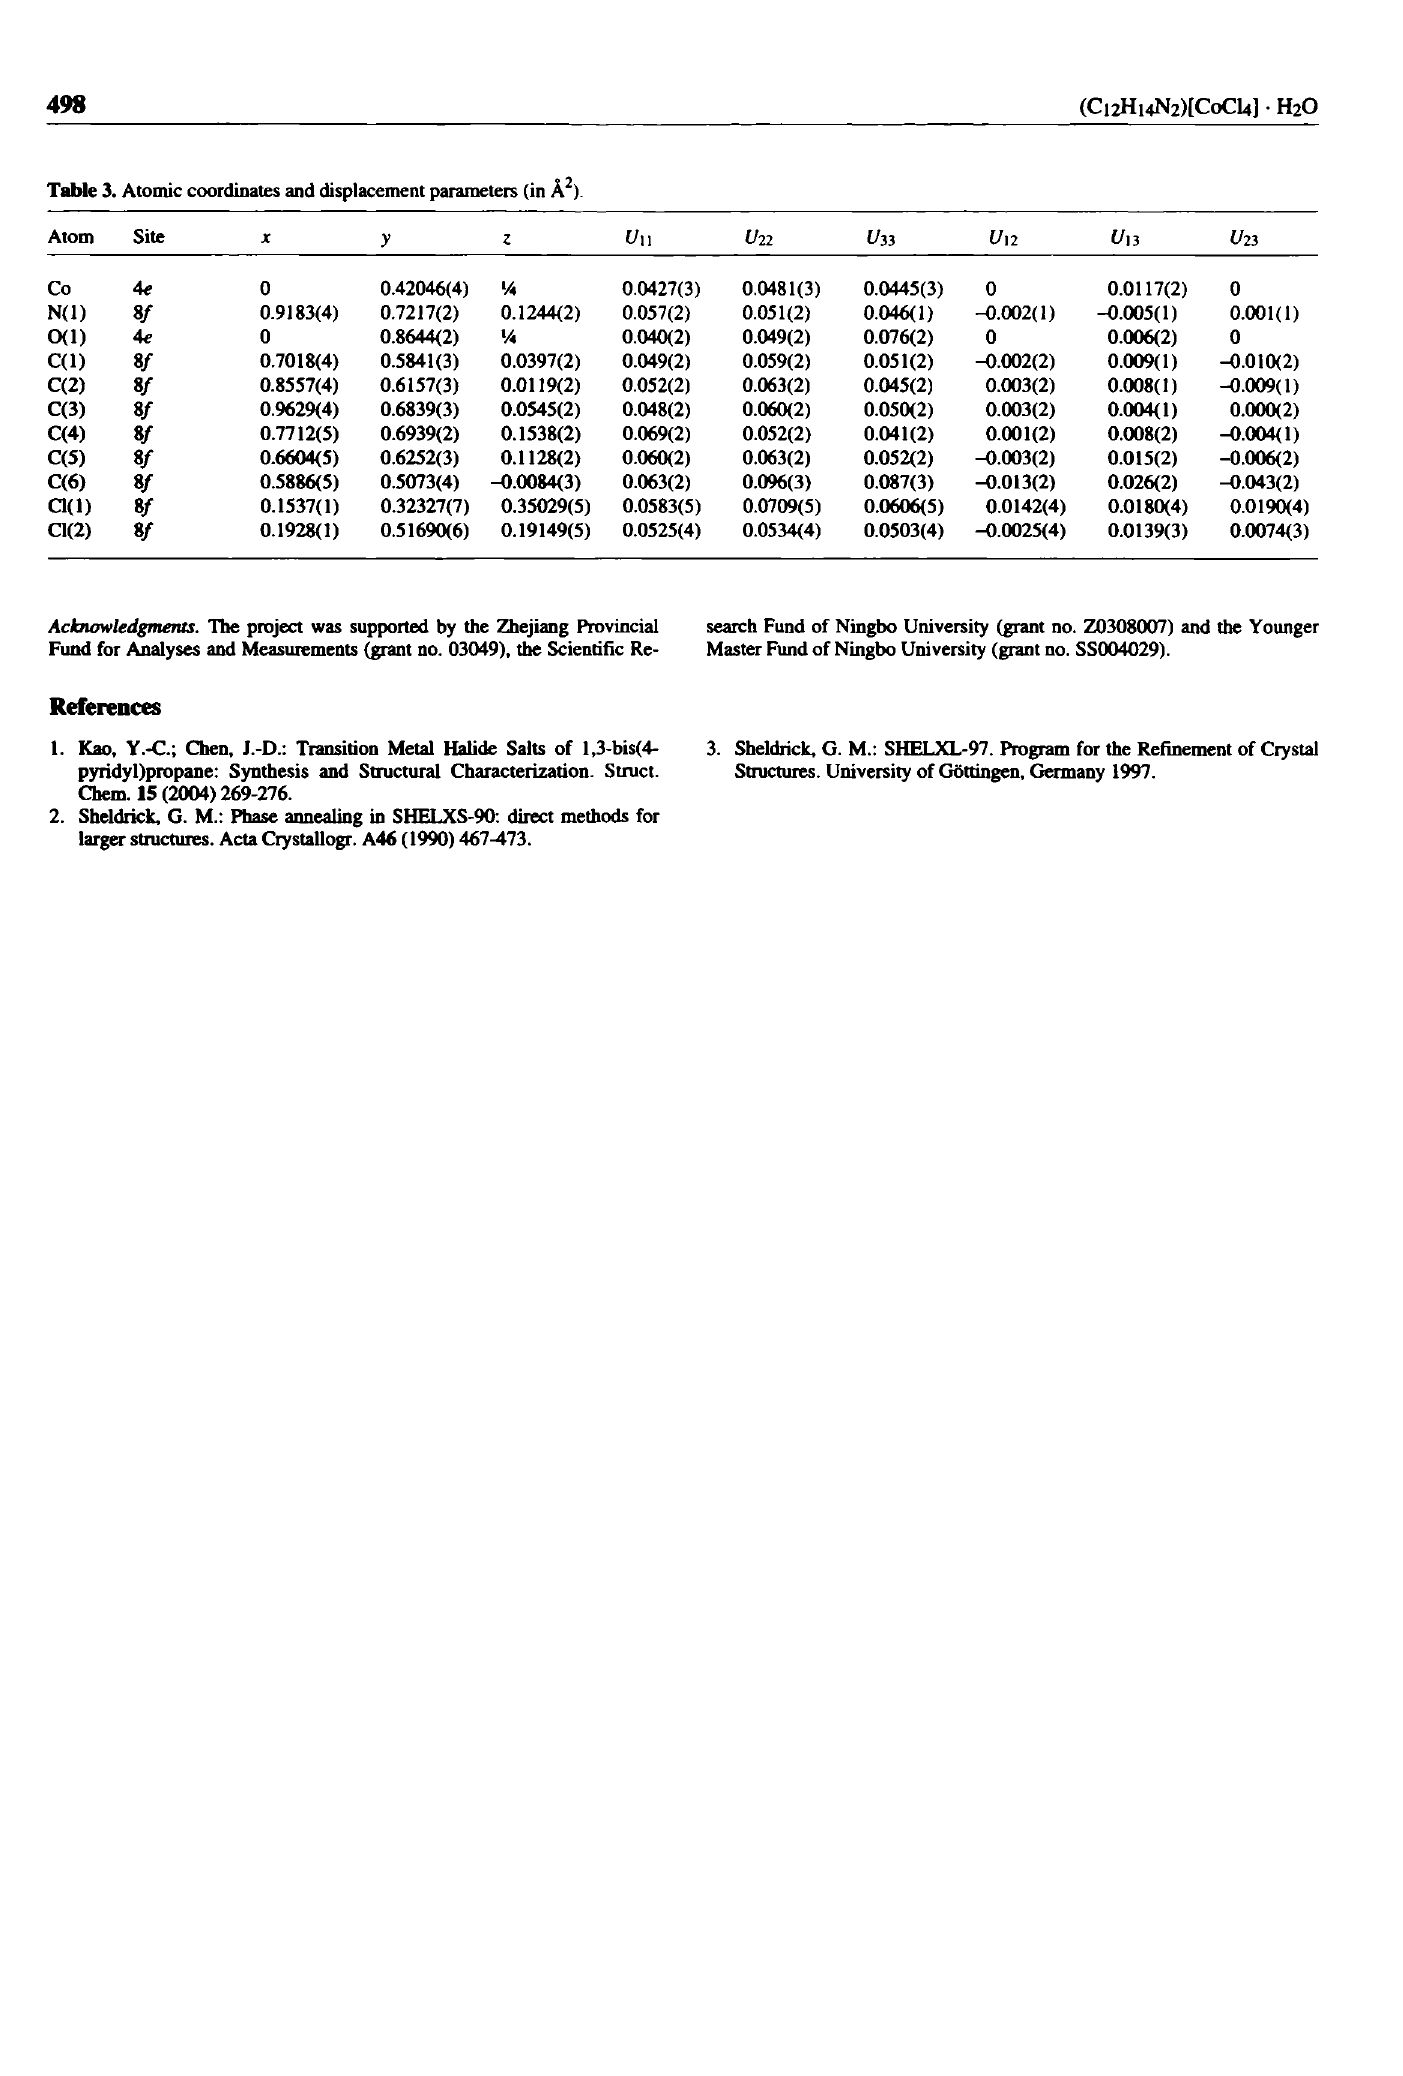
Table 3. Atomic coordinates and displacement parameters (in A 2